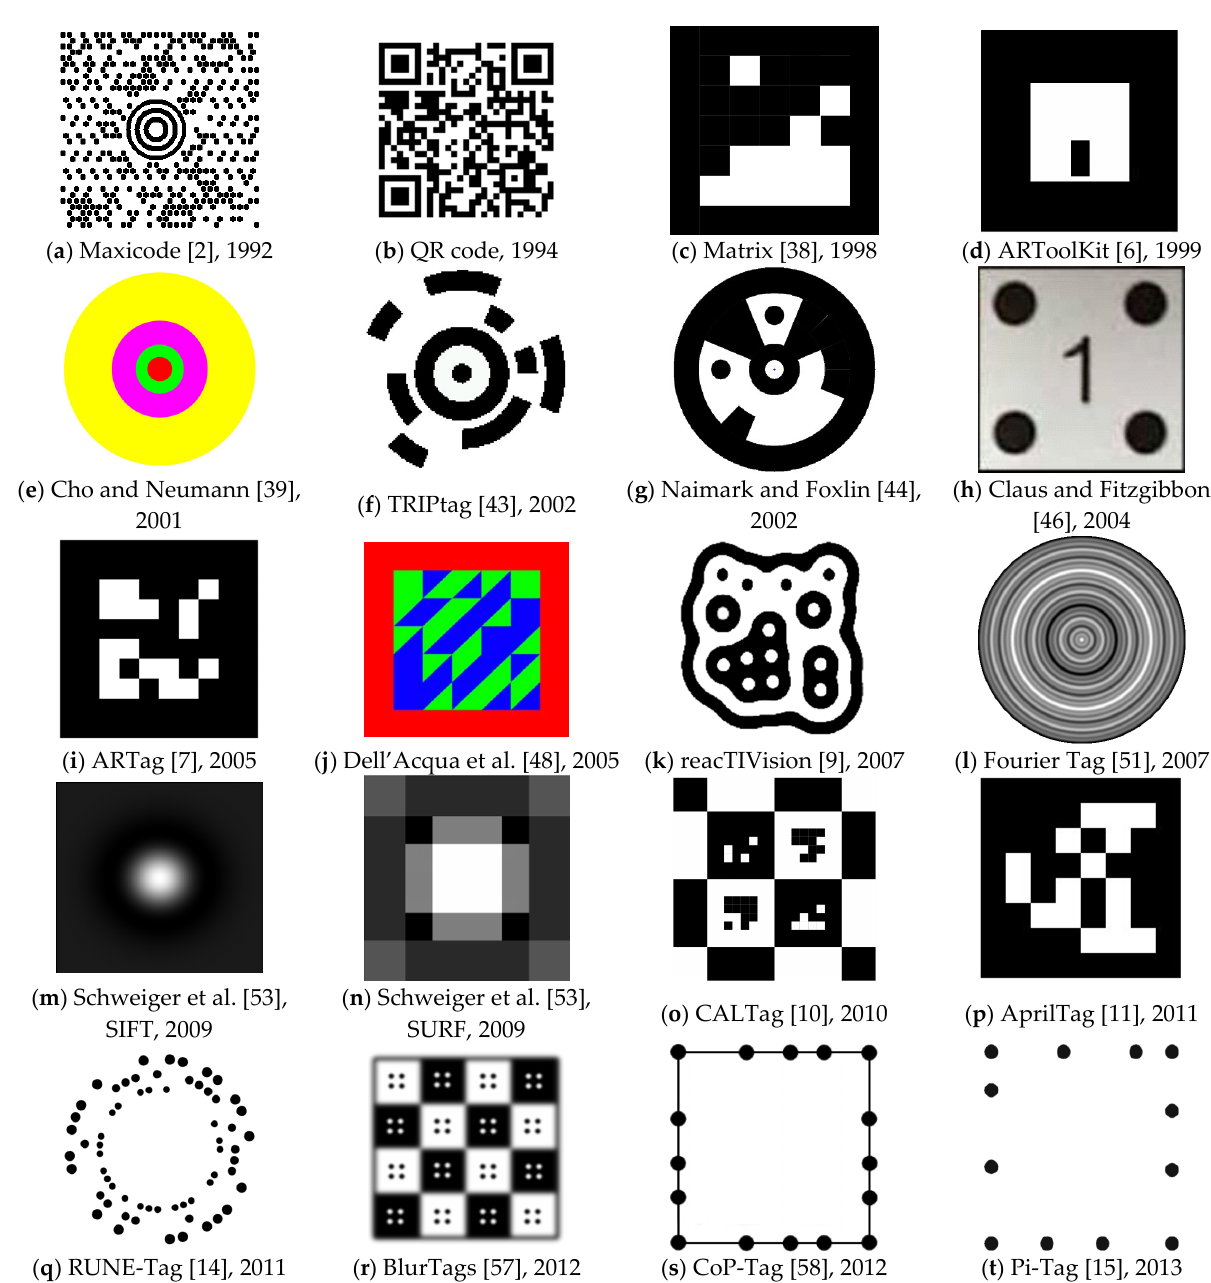
Figure 1. Examples of the most notable marker systems with their name (if available) and year of their publication. Liu et al. [59] published a marker system that uses color markers (see Figure 2a) in 2013. High contrast between black and white in other systems makes the marker easily extracted. However, the adaptability to illumination changes is low. Using a color marker should overcome these issues. Also, a color marker usually matches the surroundings more naturally. The system’s primary goal is tracking the target object in real-time and registering a virtual 3D object. The authors state that RGB and HSV color models are not flexible enough for illumination changes. Therefore, they present a new method for recognizing a color marker in an image. The authors do not use a quadrilateral shape, as many other authors do, but instead they use an equilateral triangle. The main drawback is that the authors only compare their solution with ARToolKit [6], which was already